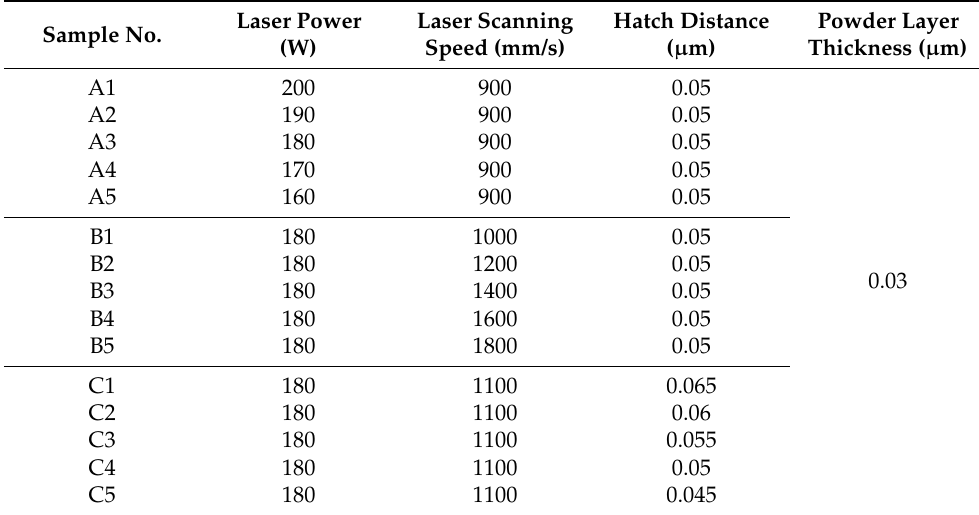
Table 1. Operating conditions to print 15 specimens via the LPBF process. Sample No.